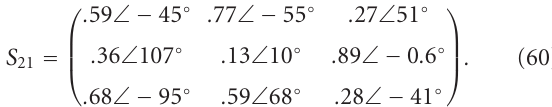
Figure 6: Plot of the realized gain (dB) versus theta for the excitation that maximizes this quantity. The phi cut is the plane containing the maximum gain value of 9.3